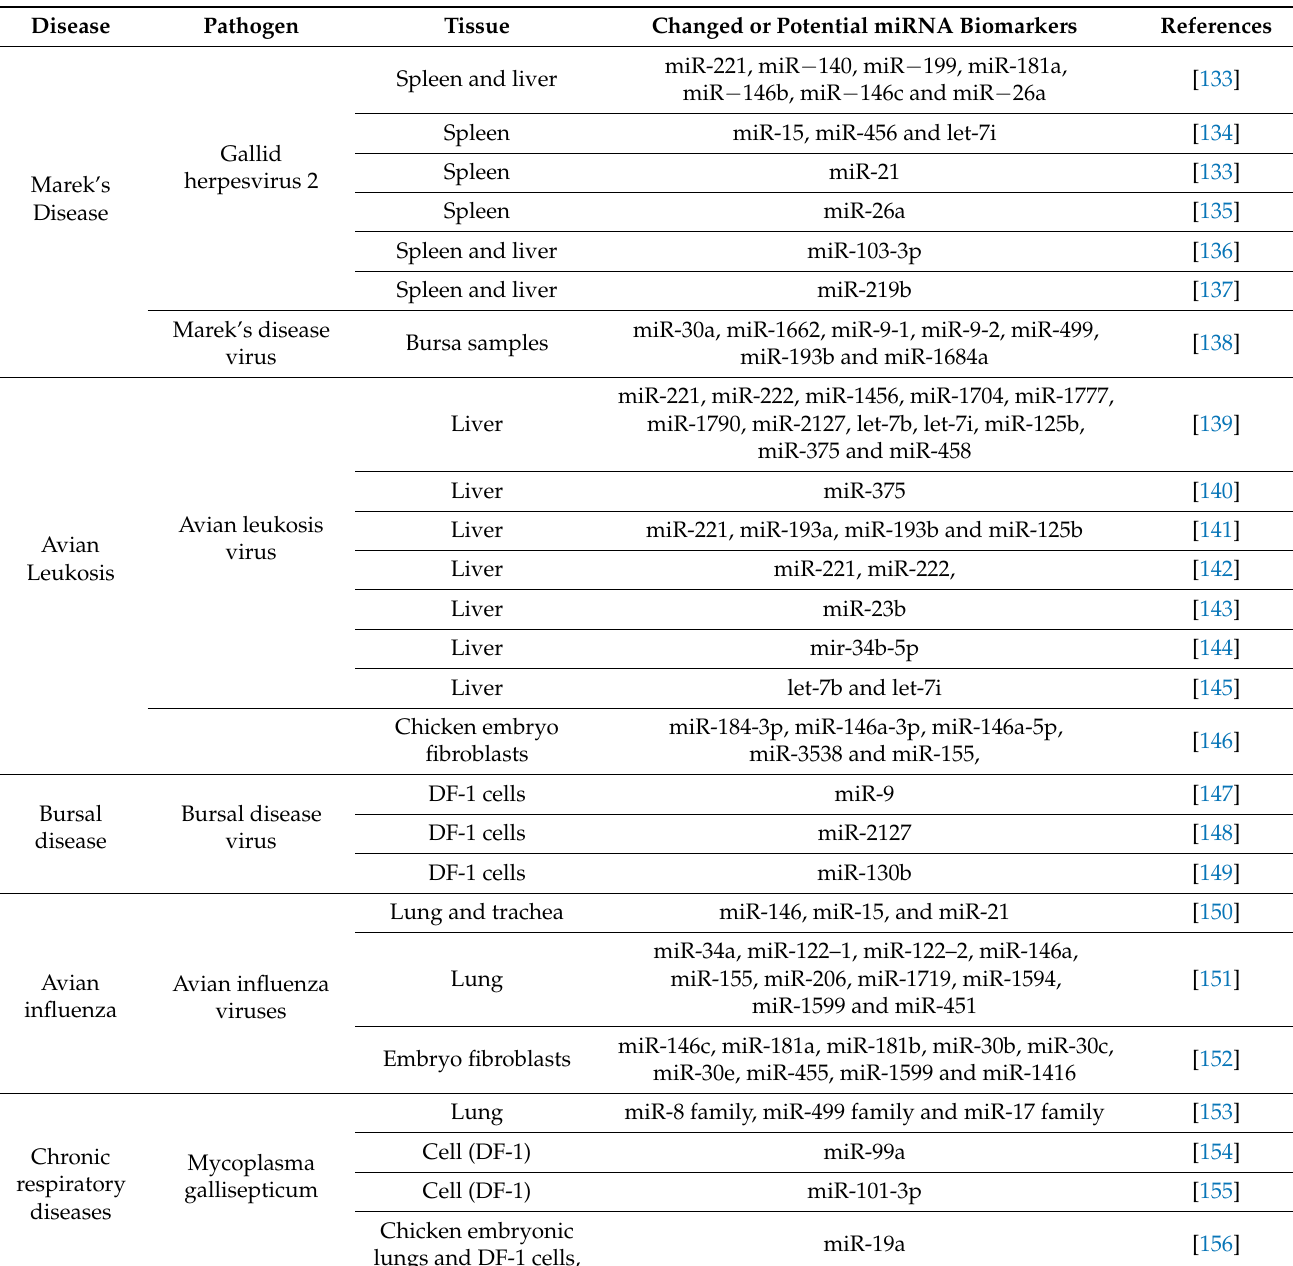
Table 4. Important miRNAs for chicken